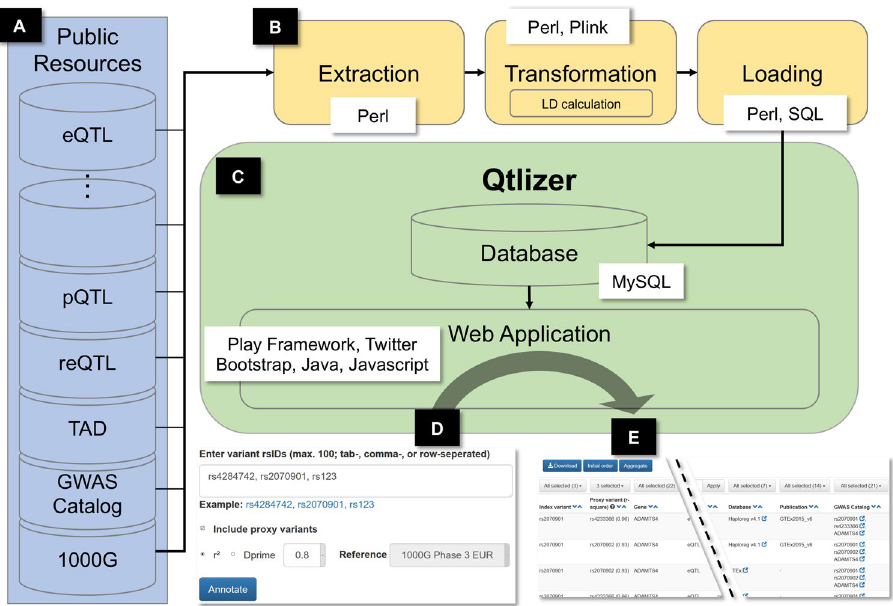
Figure 1. ( A ) Data from various publicly available resources was integrated ( B ) applying an Extraction, Transformation and Loading (ETL) process. ( C ) Qtlizer consists of a relational database and a web application ( D ) Qtlizer can be queried for QTL data via the web-based user interface or programmatically by inputting lists of genetic variants and genes using a REST API. ( E ) Annotation results are displayed in a table